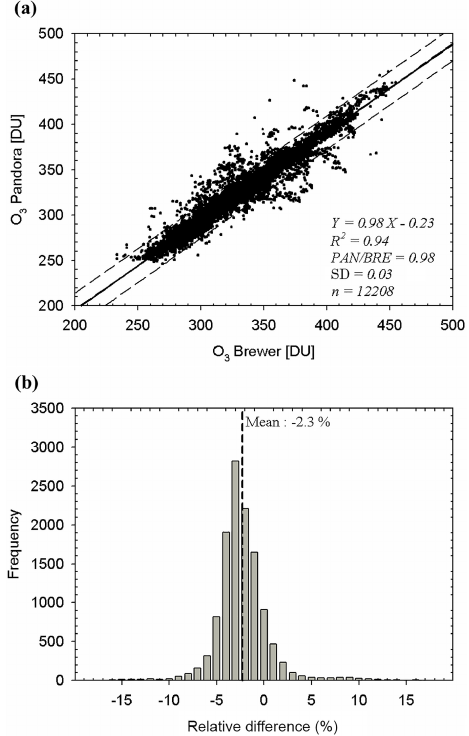
Figure 7. (a) Intercomparison of TCO amount and (b) histogram of relative difference between BRE and PAN based on the real-time data, with an observation time difference less than